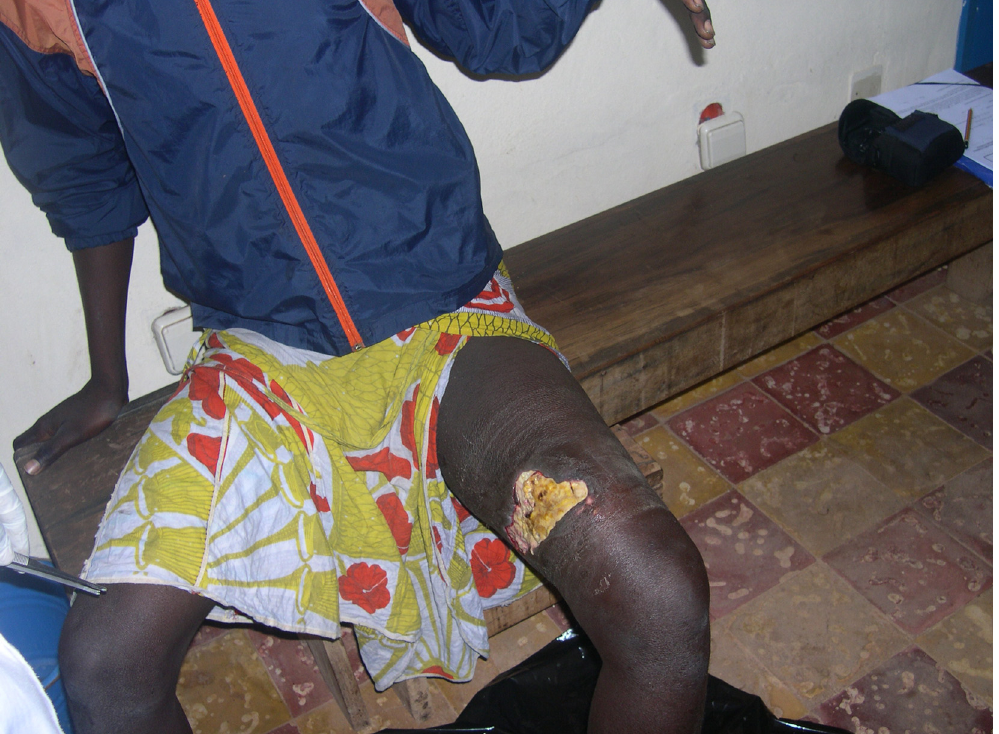
Fig 2. Buruli ulcer case in the sanitary district of Tiassalé, south Côte d ’ Ivoire (case-control study, August-September 2012, Source: N ’ krumah et al.).